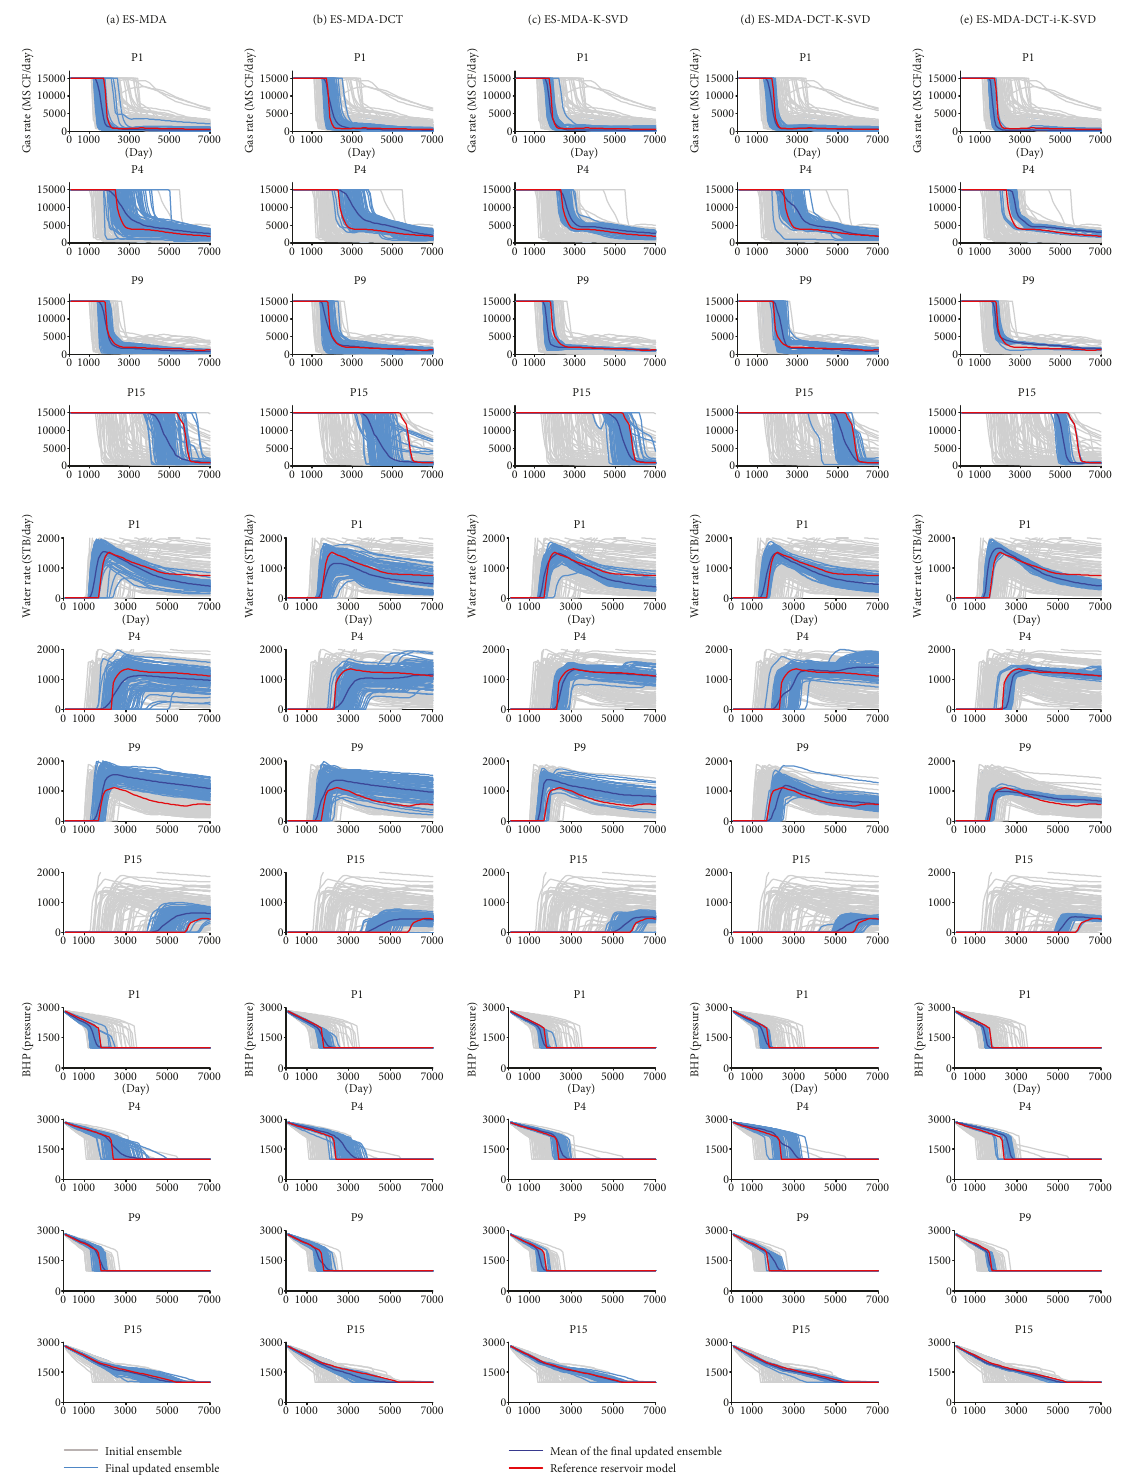
Figure 8: History matching results of Case 1: gas production rate, water production rate, and BHP measured at wells P1, P4, P9, and